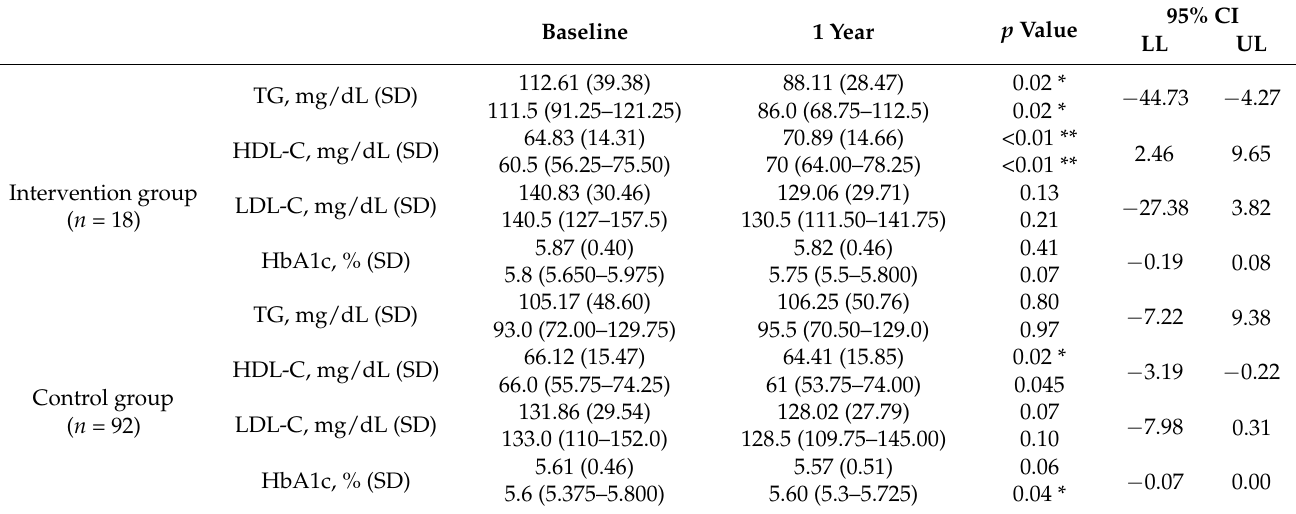
Table 2. Blood measurements at baseline and after 1